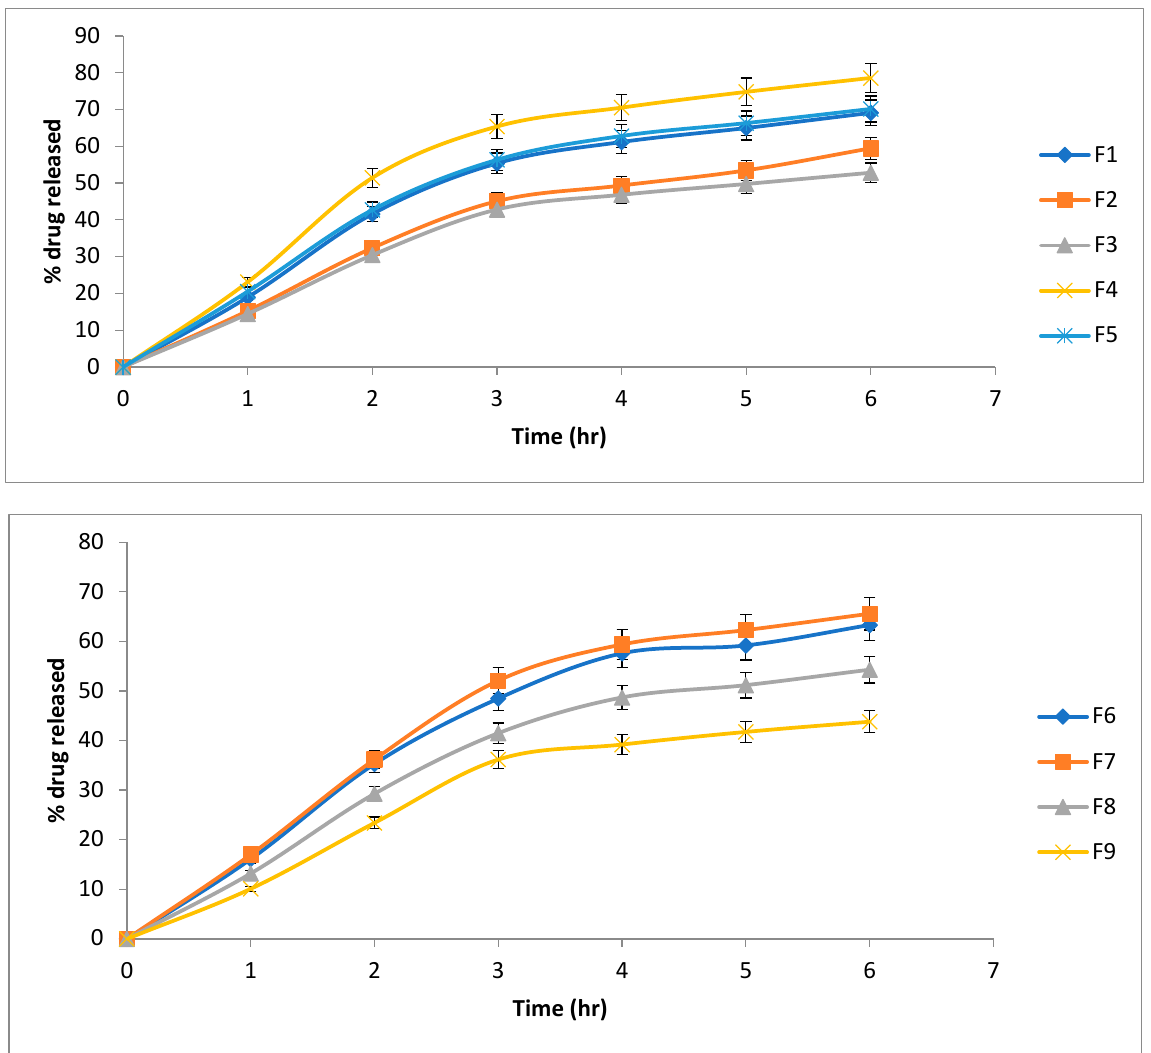
Figure 2. Release profiles of QT from formulated lipospheres (mean ± SD).